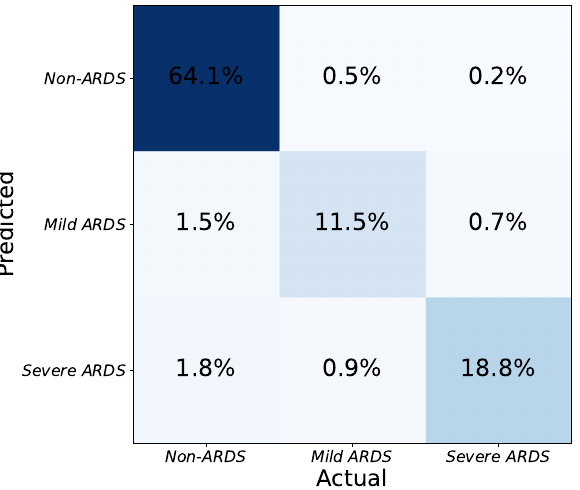
Figure 6. Confusion matrix for classification of ARDS severity with three levels (none, mild,